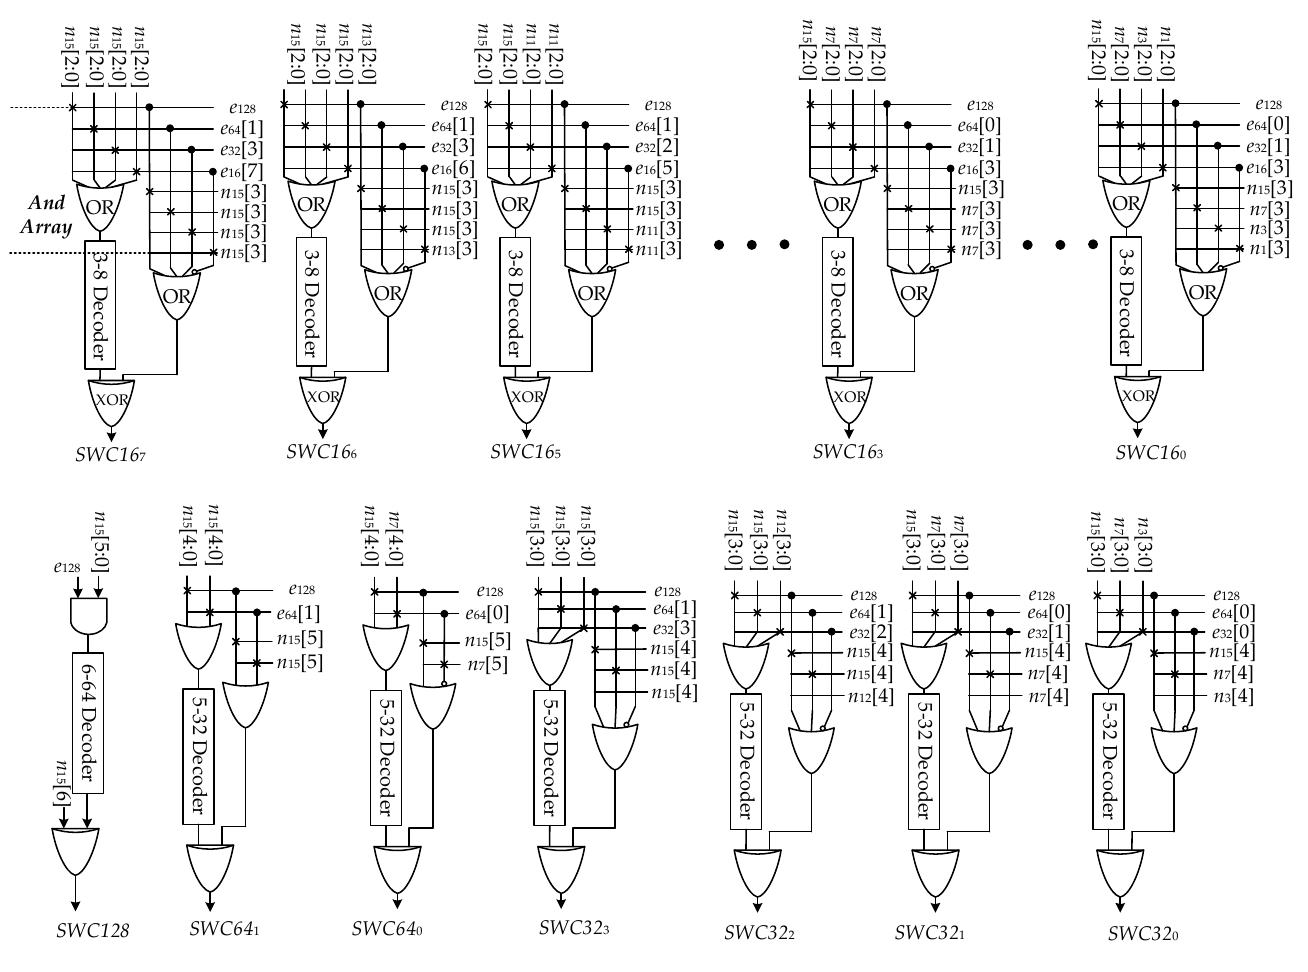
Figure 9. Part of the circuit structure for generating SWC .